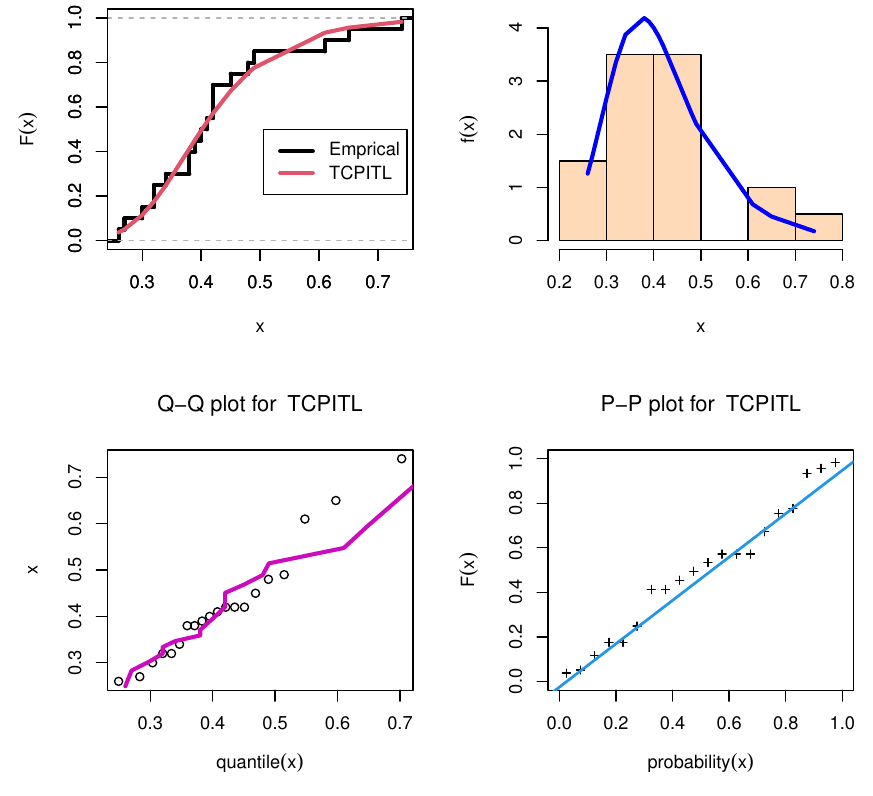
Figure 9. Fitted PDF for flood level data set III.